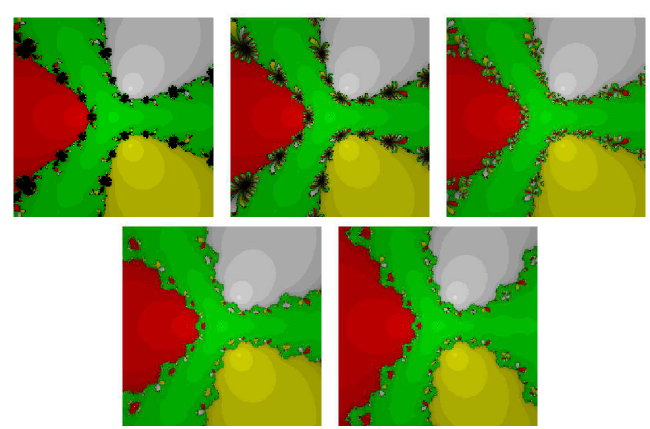
Figure 4. The basins of attraction for SM 4 , ZM 4 , SSM 4 , LM 4 and OM 4 , from left to right and top to bottom, respectively in Problem 2.